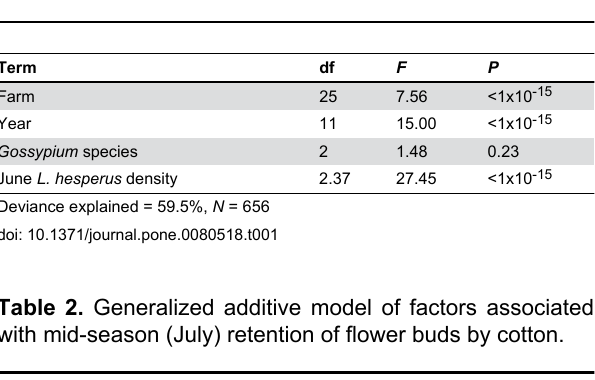
Table 3. Generalized additive model of factors associated with yield of cotton, Gossypium